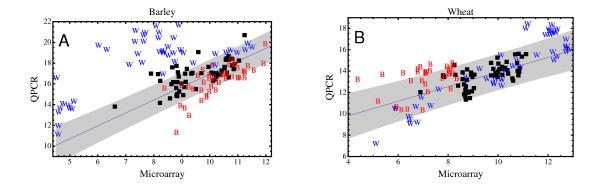
Validation of selected barley and wheat expression profiles via QPCR. A comparison of logarithmic fluorescence intensities, as measured on the microarrays, with logarithmic QPCR expression levels is shown. Barley data is shown in Panel A and wheat data in Panel B. Four wheat and four barley sequences where the average microarray fluorescence intensity for wheat is greater than barley give rise to the expression levels labelled by "W" (This comparison is carried out individually for each of the eleven tissues, hence there are a total of 44 points marked "W"). Three wheat and four barley sequences where the microarray fluorescence intensity for wheat is less than barley are marked by "B". Plain black data points indicate five sequence pairs where the microarray fluorescence intensities for wheat and barley are comparable. Data from these five sequence pairs were used to generate a calibration curve between the QPCR and microarray data in the form of a straight line fit (solid line) and associated 95% single prediction confidence limits (shaded region).